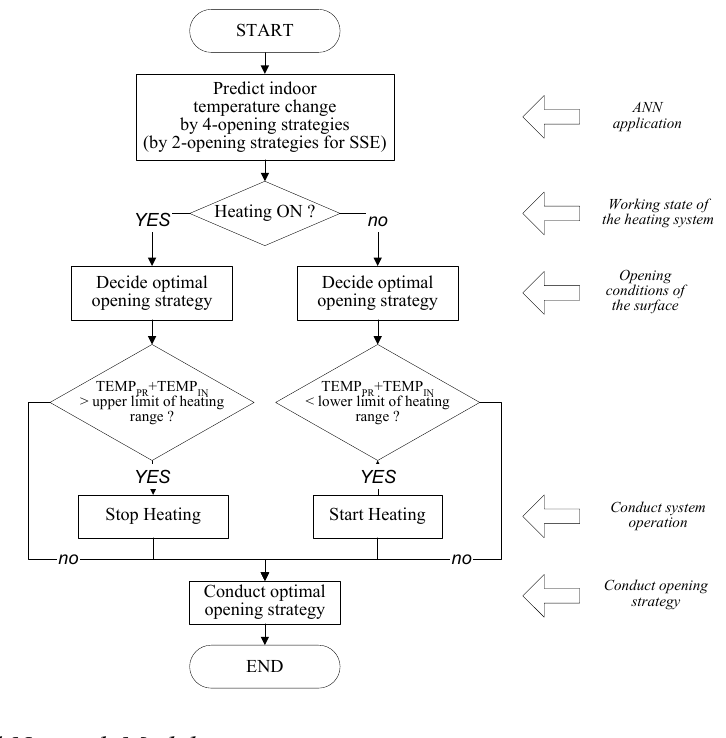
Figure 2. ANN-based temperature control logic for double and single skin